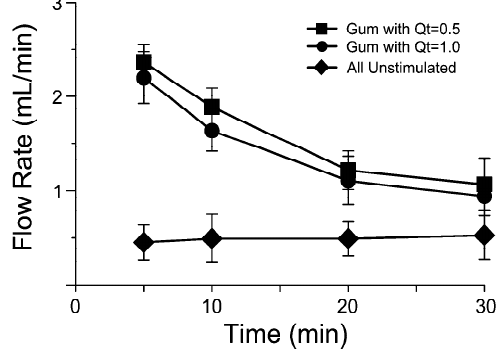
Figure 1. The changes in salivary flow rate (mean ± S.D.) for 32 participants (three samples for each participant, for three experiments) over a 30 min period, collected at 5, 10, 20, and 30 min. Qt: quercetin.